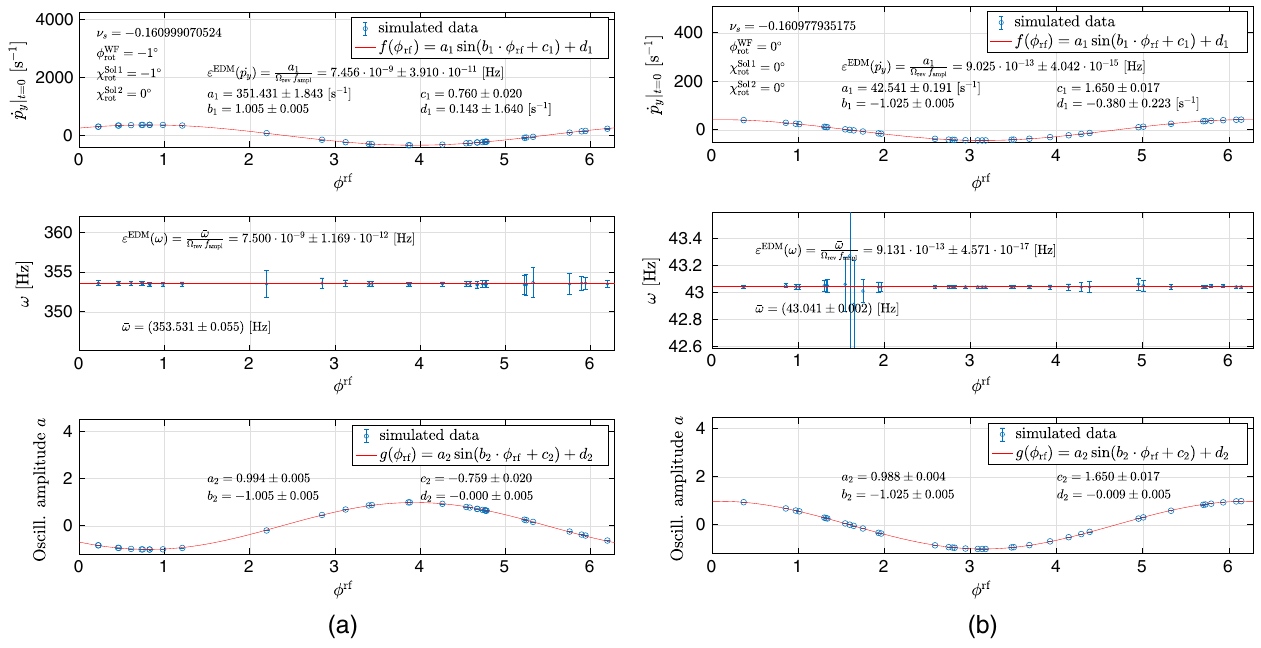
FIG. 19. Two examples showing 36 random values of ϕ that are used to obtain the resonance strengths ε EDM from graphs like the rf ones shown in Fig. 18, using Eqs. (106) and (107) for combinations of the Wien filter and solenoid spin rotation angle, denoted by ð ϕ WF Þ . Depicted here as a function of the randomly chosen ϕ ð t Þj ; χ Sol are the extracted initial slopes _ p , ω ¼ Ω p y , and the amplitude y rf rot rot t ¼ 0 ¼ 2 × 10 4 , n ¼ 200 , and d ¼ 10 − 20 e cm. To a of the p oscillation [Eq. (108)]. The parameters used for the calculation are n y turns points ¼ 10 5 , and the assumed EDM is d ¼ 10 − 17 e cm, i.e., 1000 times larger than in (a). For the beam, enhance the effect, in panel (b), n turns the conditions of Table I apply. The rf Wien filter is operated at harmonic K ¼ − 1 . The extracted resonance strengths are summarized in Table VI.